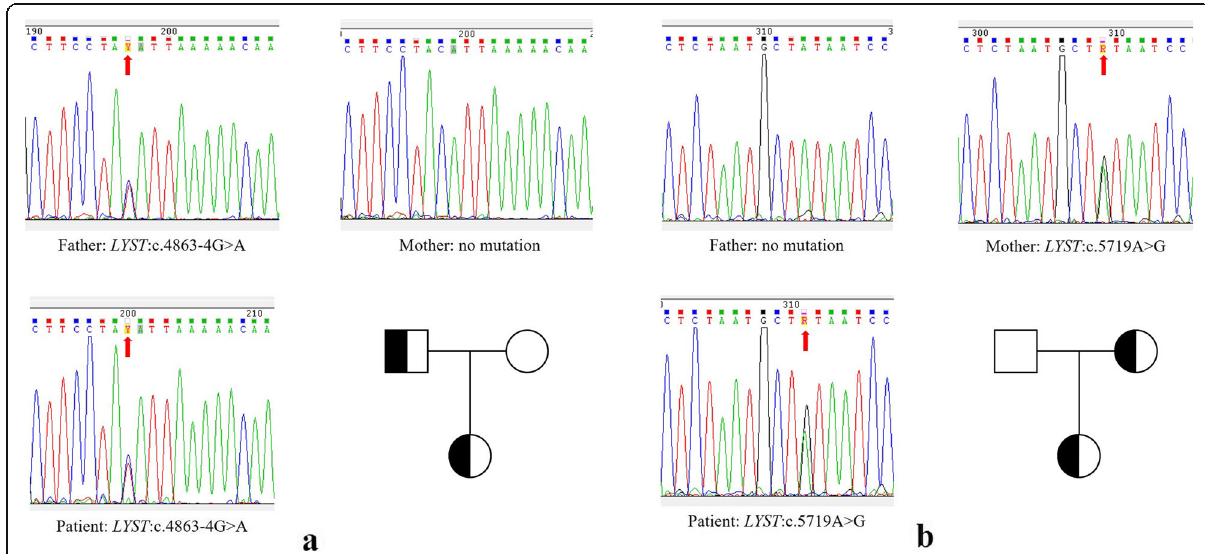
Fig. 2 Identified variations in LYST gene. a. Reported intron mutation (c.4863-4G > A) in exon15, inherited from father. b. Novel missense mutation (c.5719A > G) in exon19, inherited from mother. Mutations are marked with red arrow. Zygosity is showed by letters of degenerate bases (Y for C/ T, R for